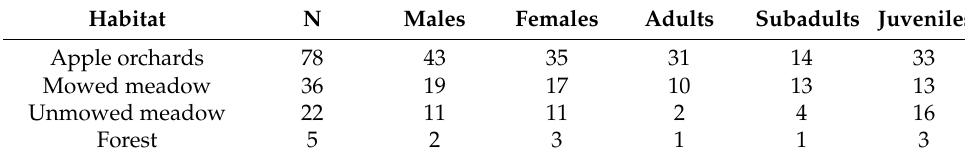
Table 1. C. glareolus sample sizes used for stable isotope analysis by habitat, age and gender. Habitat N Males Females Adults Subadults Juveniles Apple orchards 78 43 35 31 33 Mowed meadow Unmowed